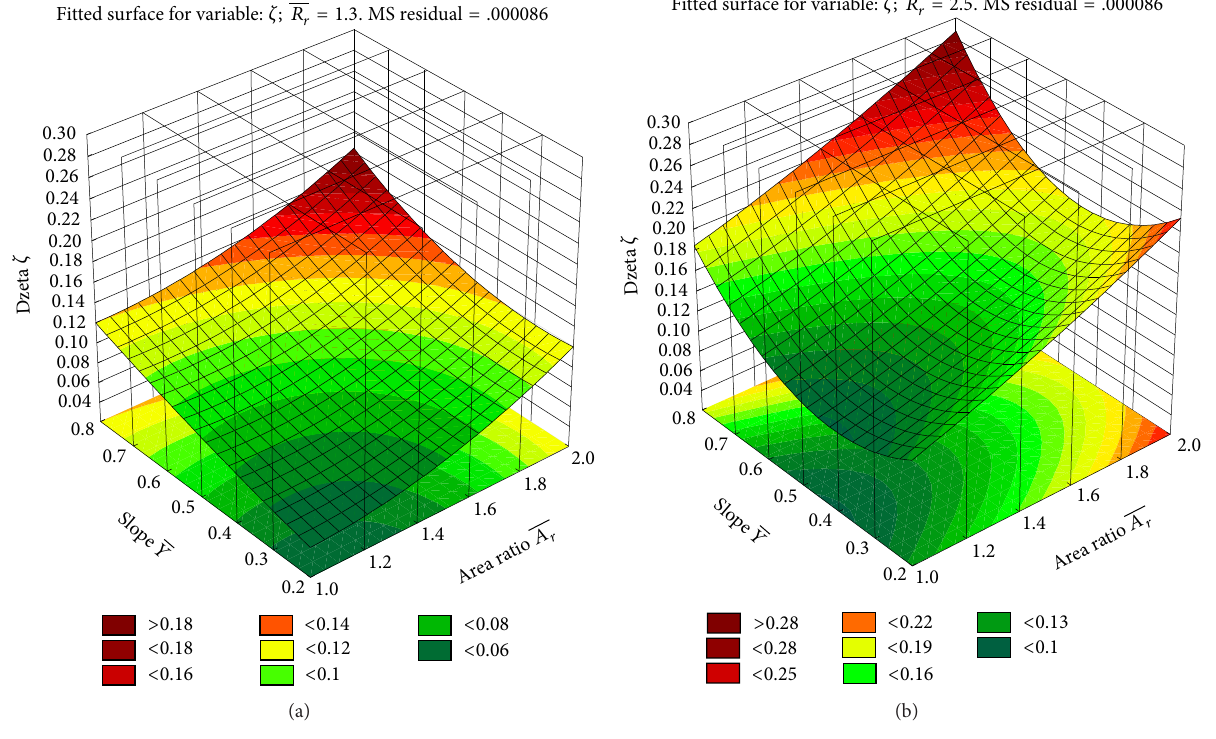
Figure 8: Response surface of output criteria 𝜁 at 𝑅 𝑟 = 1.3 (a) and 𝑅 𝑟 = 2.5 (b) for 𝛼 0 = 0 ∘ .